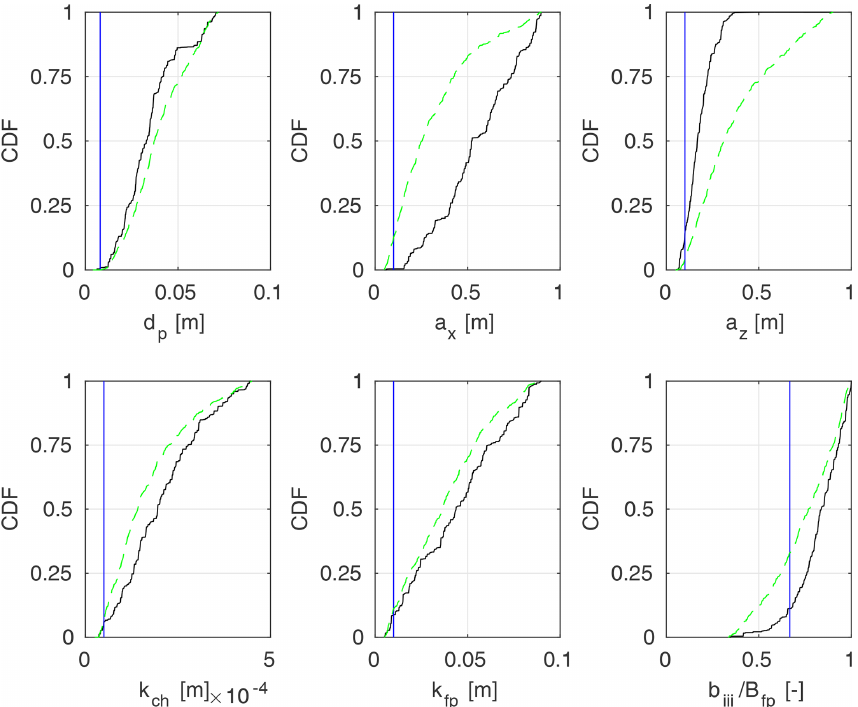
Figure 16. Marginal a posteriori distributions of Pasche (black lines) and Mertens (green lines) model parameters, identified using m = M observation points for the flume experiment, case 2; measured parameter values were provided with blue